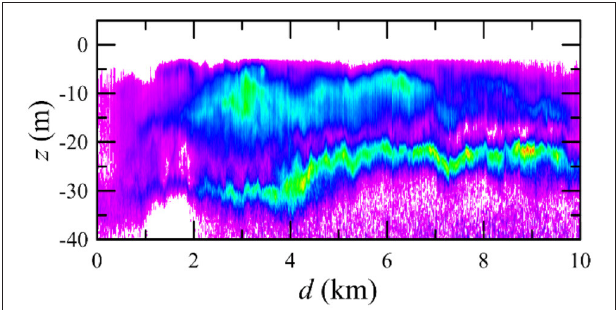
FIGURE 1 | Cross-polarized lidar return from phytoplankton layers in the NE Pacific Ocean as a function of depth, z , and distance along the flight track, d . The color represents the intensity of the lidar signal. Reuse with permission from Churnside and Donaghay (2009).